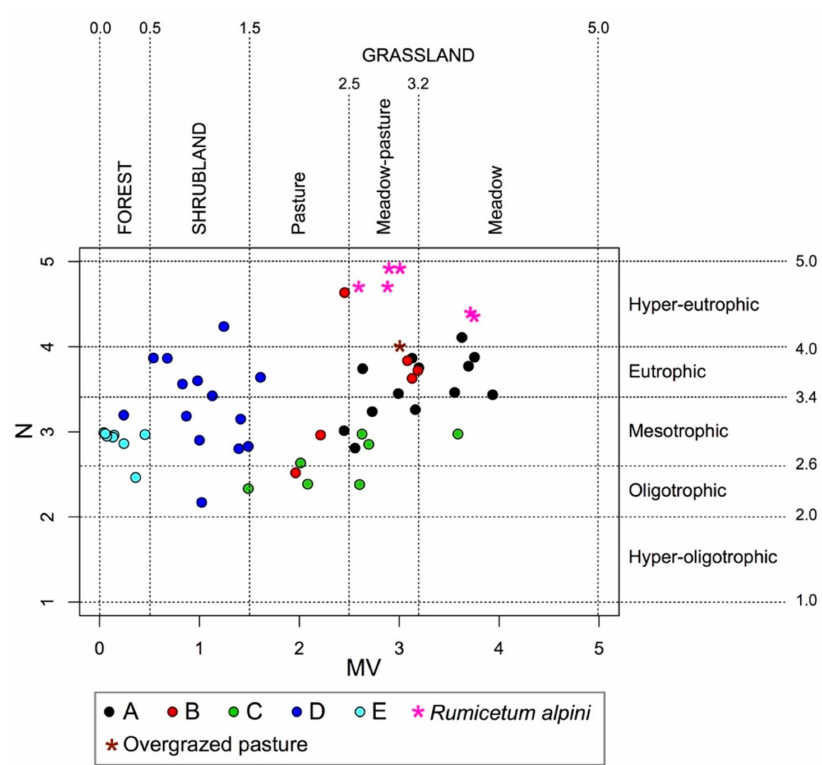
Figure 5. Scatter plot of MV (mowing tolerance) and N (index of nutrients). The graph shows the relev é s performed in Taleggio Valley (dots: A, meadows; B, meadows-pastures; C, pastures; D, shrublands; E, forests), the relev é s of Rumicetum alpini [48] and the relev é of overgrazed pasture [18] (Table S1). The grid with the 25 vegetation categories and the respective threshold values are shown.